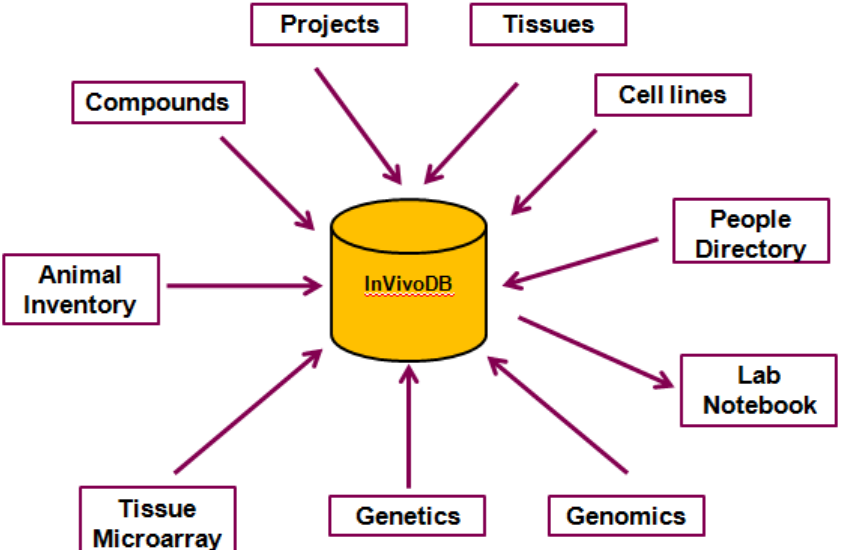
Figure 2: Interactions of InVivoDB with other AZ